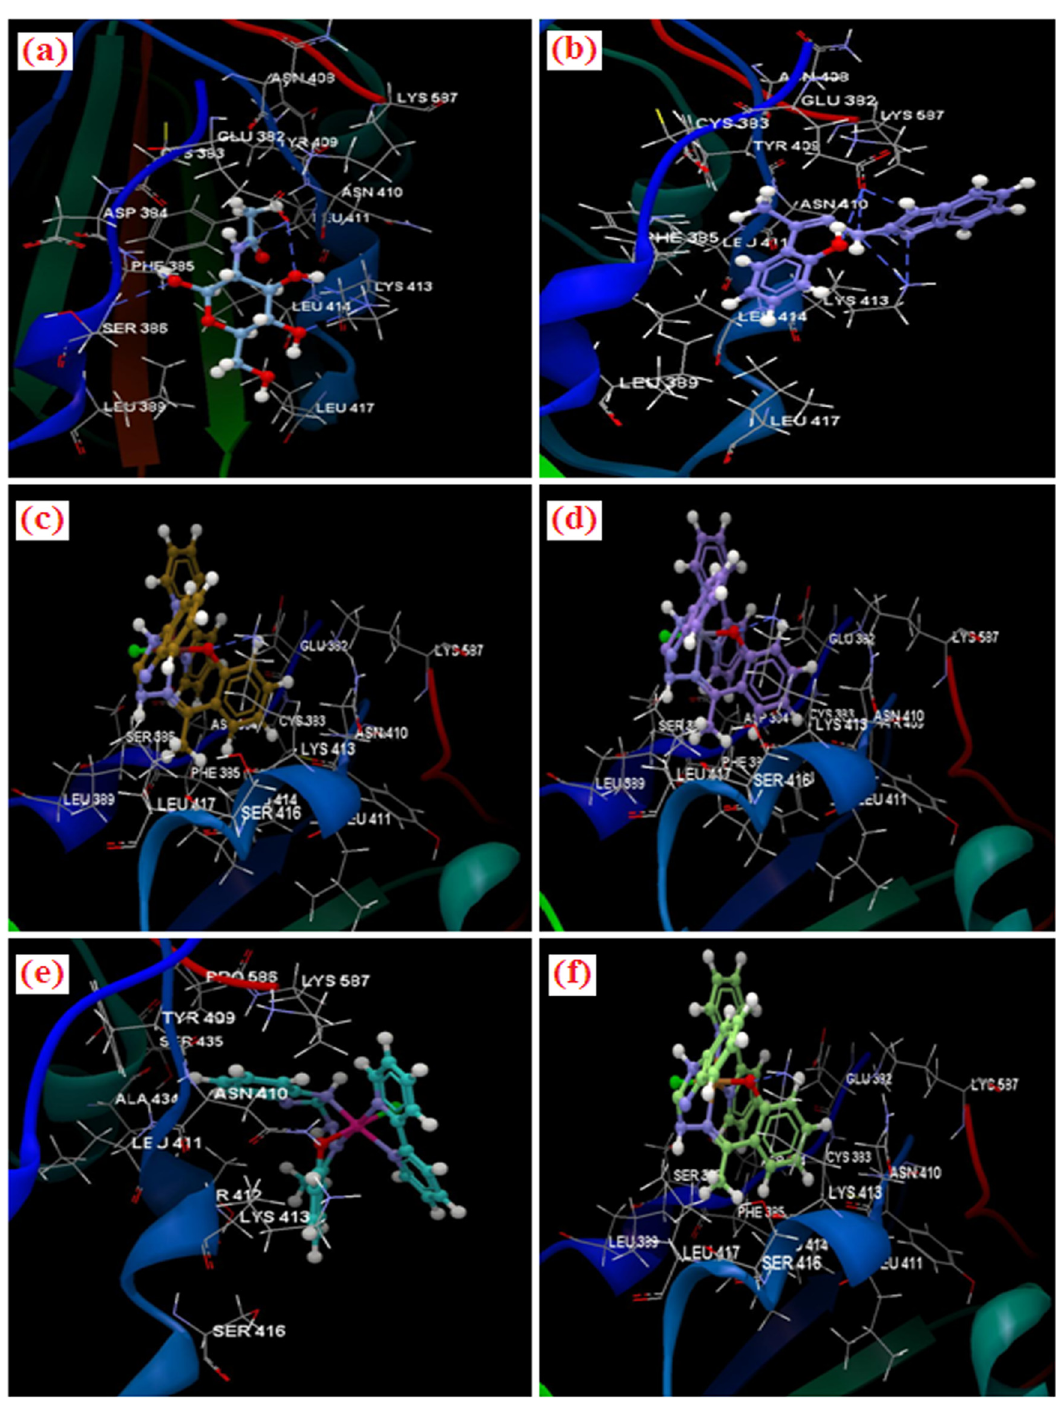
Figure 3: Docking pose of the compounds interacting with the residues of amino acid of binding site of 4Z6S; ( a ) co - crystallized NAG, ( b ) Schi ff base ligand, ( c ) Ni ( II ) complex, ( d ) Zn ( II ) complex, ( e ) Co ( II ) complex and ( f ) Cu ( II )